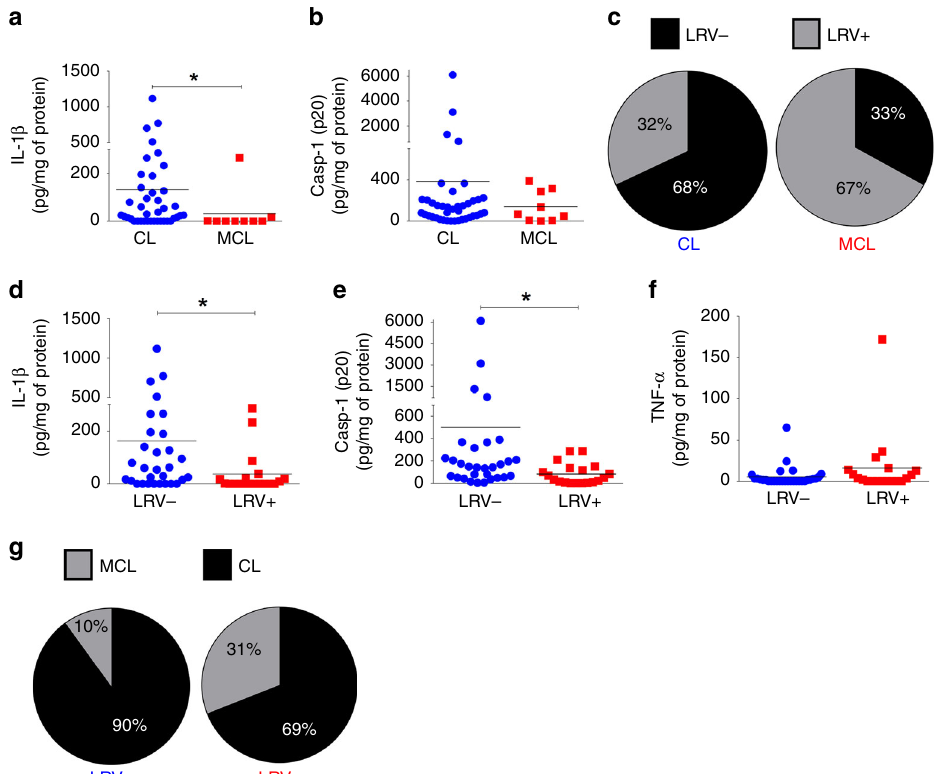
Fig. 1 LRV and MCL associate with decreased levels of IL-1 β and Casp1 p20. a – c Patients were grouped according to the outcome of the disease (CL = Cutaneous Leishmaniasis; MCL = Mucocutaneous Leishmaniasis), regardless of the infecting Leishmania specie. Levels of IL-1 β ( a ) and cleaved Casp1 ( b ) were quanti fi ed by ELISA in aspirates collected from lesions from both CL ( n = 40) and MCL ( n = 9) patients, and the frequency of LRV + and LRV − parasites among each group is shown ( c ). d – g The same group of patients was distributed according to their LRV status, regardless of the infecting Leishmania specie. Levels of IL-1 β ( d ), cleaved Casp1 ( e ), and TNF- α ( f ) were plotted from both LRV + ( n = 19) and LRV − ( n = 30) patients, and the frequency of CL and MCL among each group is shown ( g ). Each value was corrected to the respective amount of protein (determined by Bradford) from each patient. Statistical analysis was performed by Mann – Whitney ’ s test. P < 0.05 (*) was considered statistically signi fi